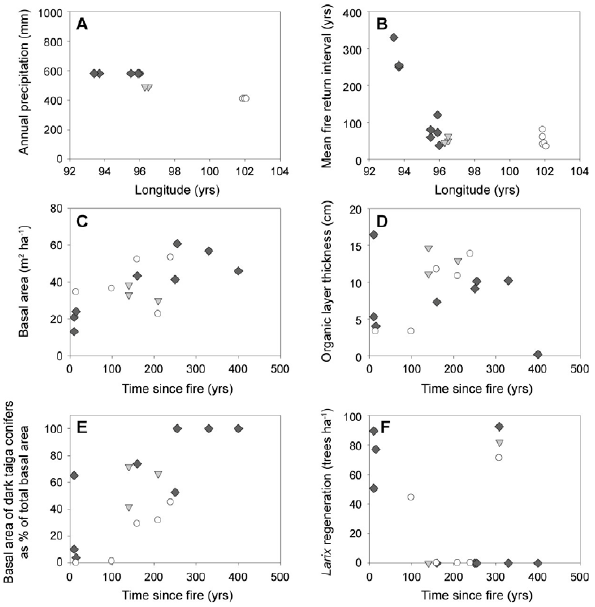
Fig. 7 Fig. 7. Annual precipitation (A) and mean fire return interval (B) as related to longitude, basal area (C) and organic-layer thickness (D) , and relative fraction of basal area of dark taiga conifers (E) and Larix regeneration (F) as related to time-since-fire.